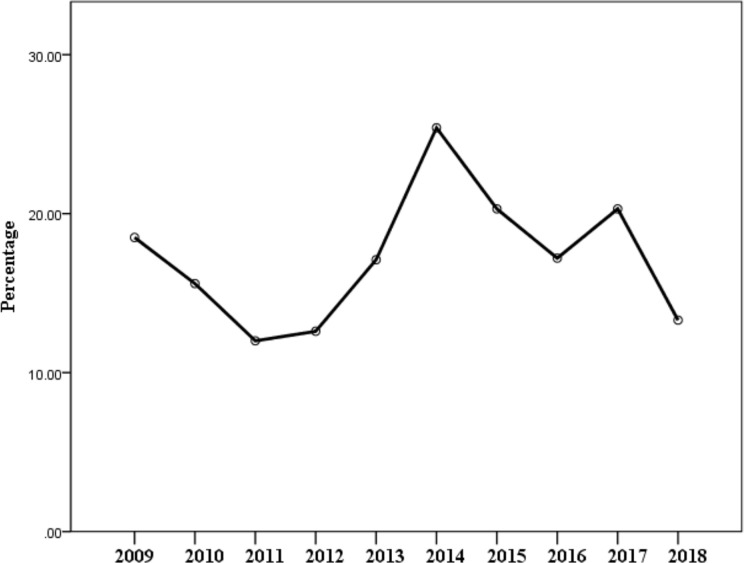
A graph illustrating the yearly cancer mortality.